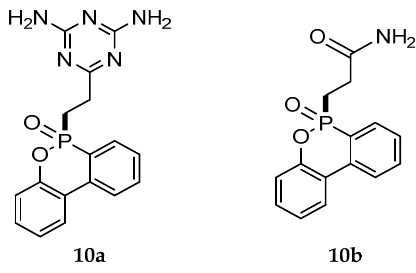
Figure 9. DOPO derivatives of 10a and 10b structures.